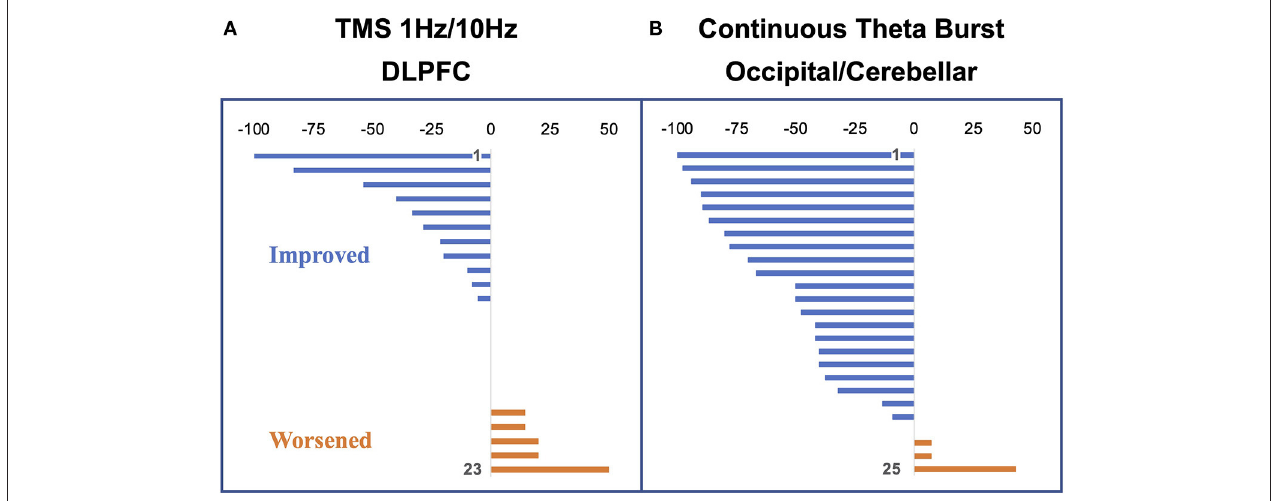
FIGURE 4 | Percent change in vertigo intensity measured as a visual analog scale change from pre to post stimulation. Negative deflections represent a decrease in symptoms; positive deflections, an increase in symptoms. (A) Participants in the dorsolateral prefrontal cortex (DLPFC) repetitive transcranial magnetic stimulation (rTMS) study (24 at baseline with one dropout). (B) Participants in the occipital/cerebellar theta burst study (26 participants with one dropout). Figure adapted from Cha YH et al., Brain Stimulation 2016 (50). and Cha YH et al., Otology Neurotology 2019